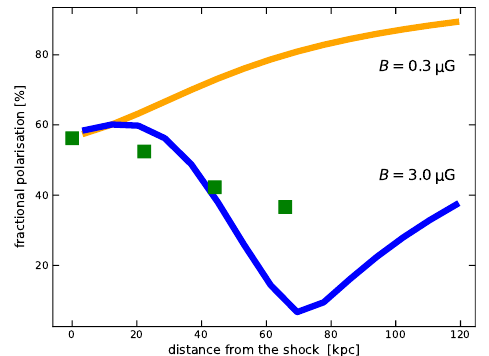
Figure 2. The downstream profile of the fractional polarisation. We investigate the profiles for a Mach number M = 4 and two magnetic field strengths, namely B = 0.3 µ G (orange) and B = 3 µ G (blue). The downstream polarisation profile has a minimum at about 70kpc, where we have adopted a shock propagation speed of 1000kms − 1 . The increase in polarisation at distances larger than 70kpc for a magnetic field strength B = 3.0 µ G corresponds to a very low surface brightness. We also plot the downstream fractional polarisation of the Sausage relic as reported in [14]. The decrease of downstream polarisation in the Sausage relic is less prominent than in our model, this may for example reflect a mixture of magnetic field strengths in the downstream